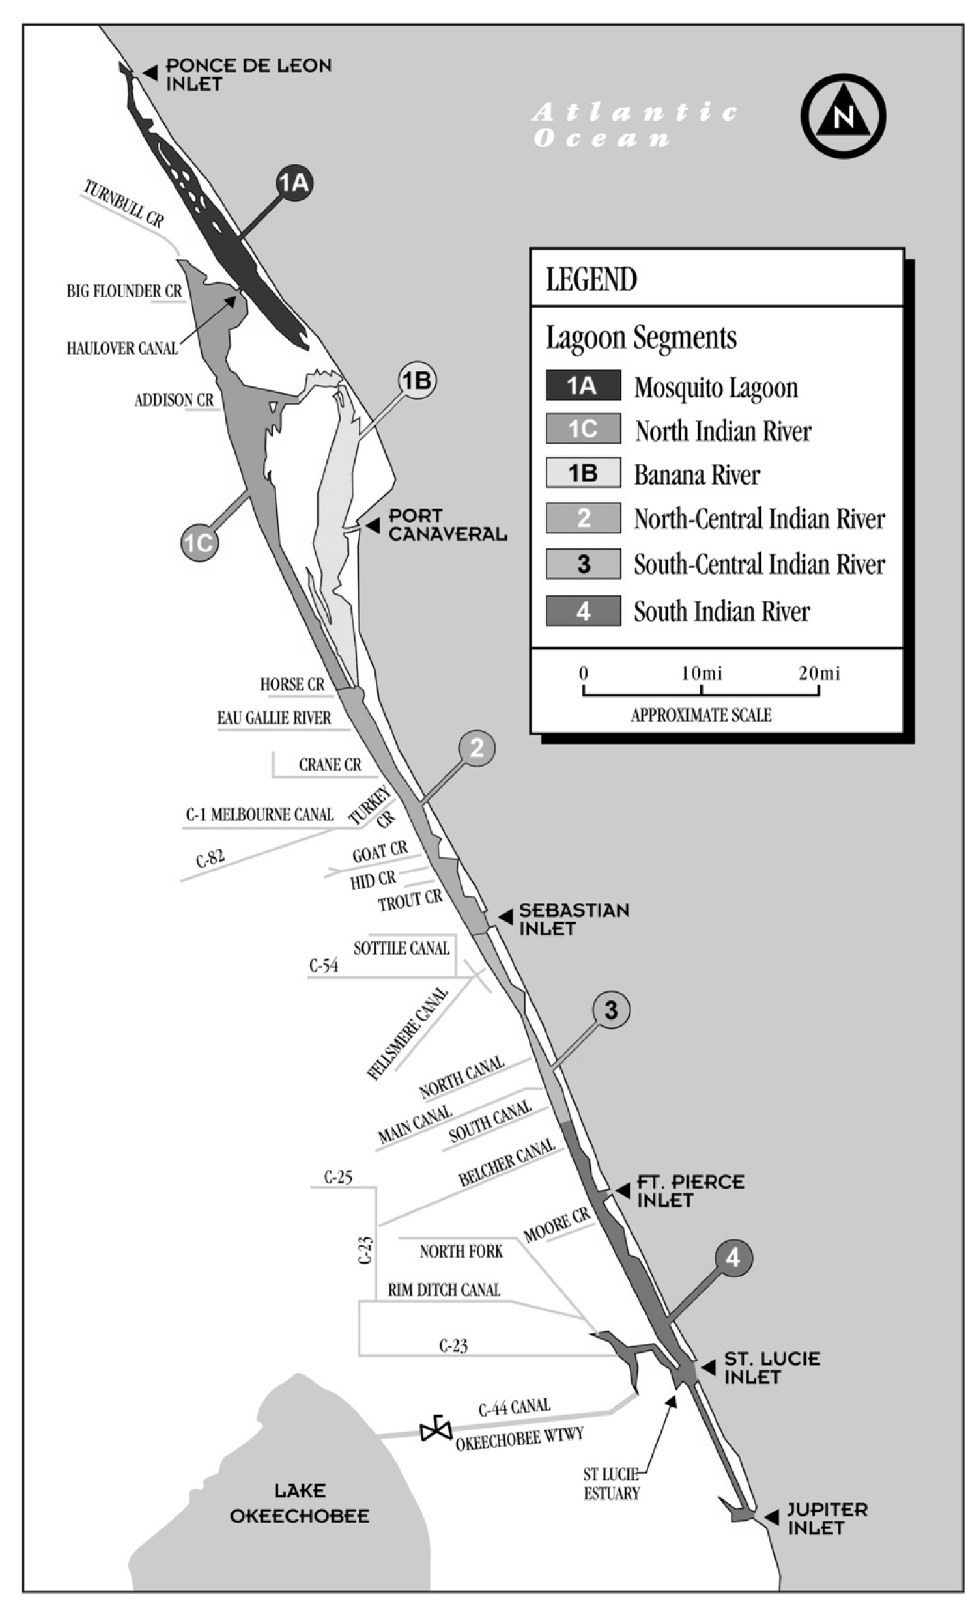
Figure 1. Map of the Indian River Lagoon with bordering counties and spatial segments of the